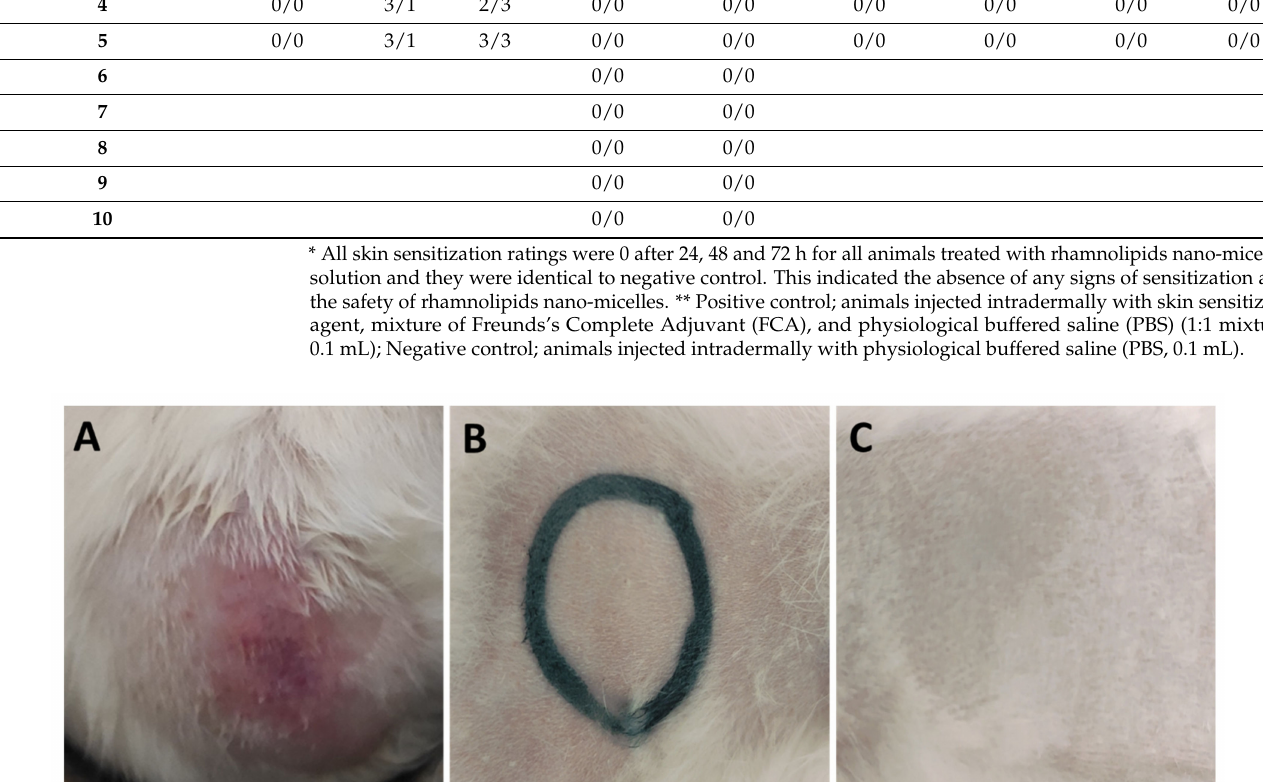
Figure 5. Representative photos of skin sensitization test for one representative guinea pigs